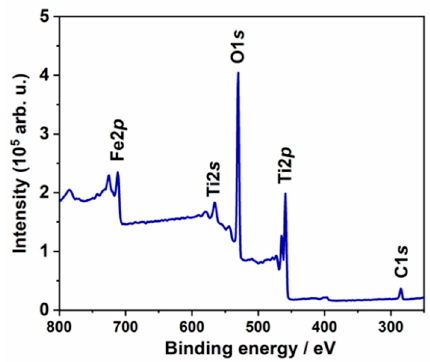
Figure 6. The XPS survey spectrum recorded for Fe10L80 sample.